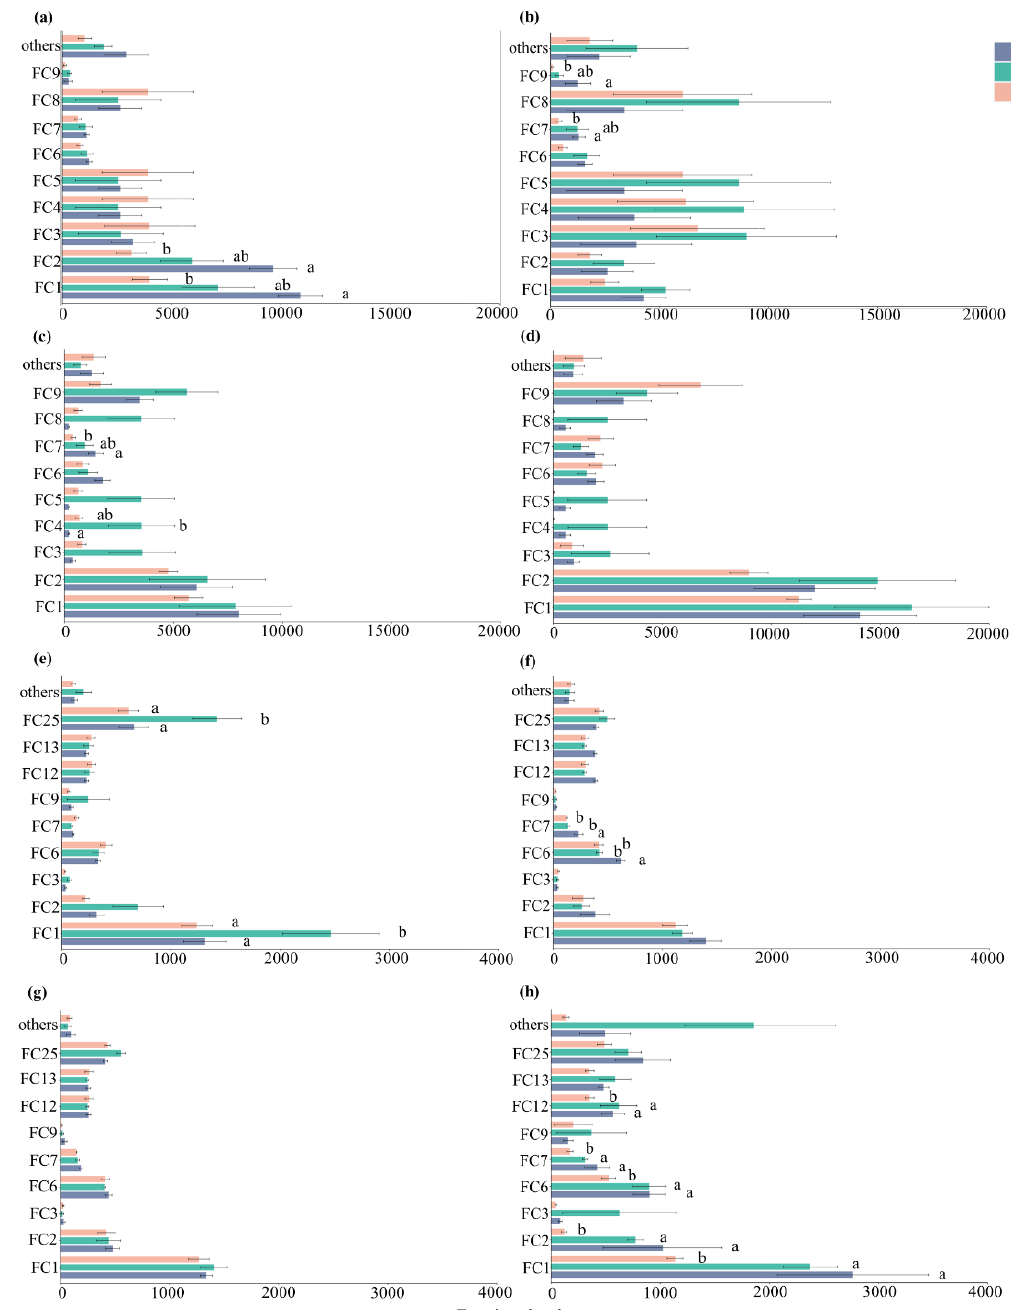
Figure 4. Columnar difference in bacterial function related to the carbon cycle in water column and sediment. All data are presented as the mean ± SE. The letters above the bars represent significant differences between treatments ( p < 0.05). ( a ), Carbon cycle of water in spring; ( b ), Carbon cycle of water in summer; ( c ), Carbon cycle of water in autumn; ( d ), Carbon cycle of water in winter; ( e ), Carbon cycle of sediment in spring; ( f ), Carbon cycle of sediment in summer; ( g ), Carbon cycle of sediment in autumn; ( h ), Carbon cycle of sediment in winter. The carbon cycle in the figure is represented by FC1–FC25, and the specific functions are chemoheterotrophy (FC1), aerobic chemoheterotrophy (FC2), phototrophy (FC3), photoautotrophy (FC4), oxygenic photoautotrophy (FC5), methylotrophy (FC6), methanol oxidation (FC7), cyanobacteria (FC8), chloroplasts (FC9), hydrocarbon degradation (FC12), methanotrophy (FC13), and fermentation